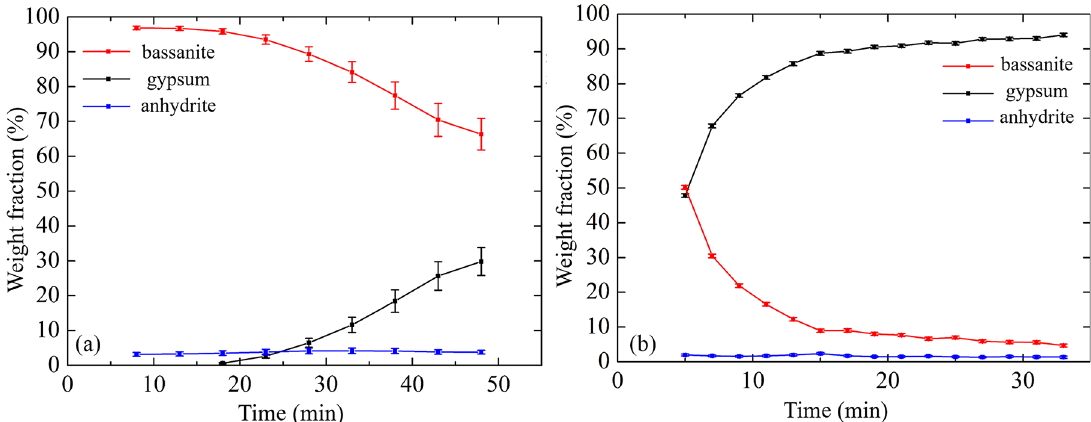
Figure 14. Mass fractions of the sulfate-based compounds (anhydrite - blue dots, bassanite - red dots, and gypsum - black dots) as a function of the hydration time of the samples (a) CP1 and (b) RP1 obtained by the parametric Rietveld